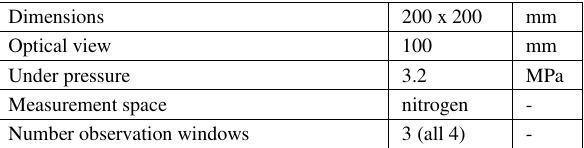
Table 1. The parameters of constant volume vessel